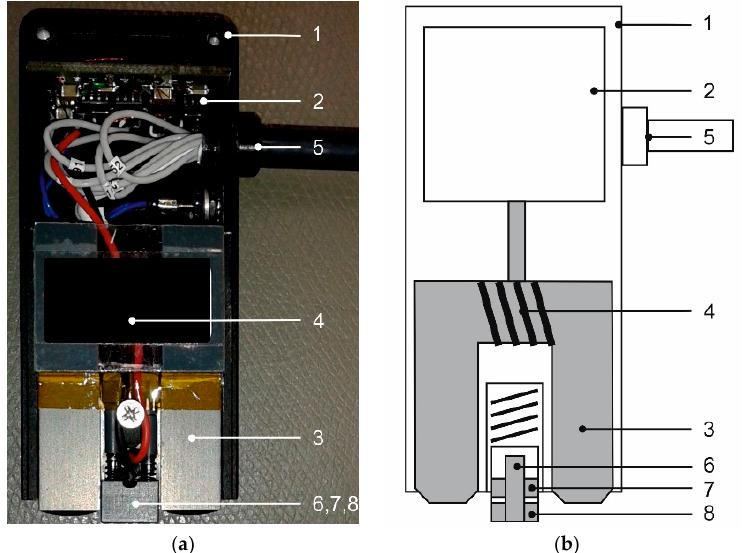
Figure 2. Micromagnetic multiparametric microstructure and stress analyzer (3MA) probe head with its components: ( a ) image and ( b ) technical sketch; 1 ‐ Housing, 2 ‐ Electronic board (preamp), 3 ‐ Magnetic yoke, 4 ‐ Magnetization coils, 5 ‐ Connection cable, 6 ‐ Hall sensor, 7 ‐ Transmitter coils, and 8 ‐ Receiver coils.